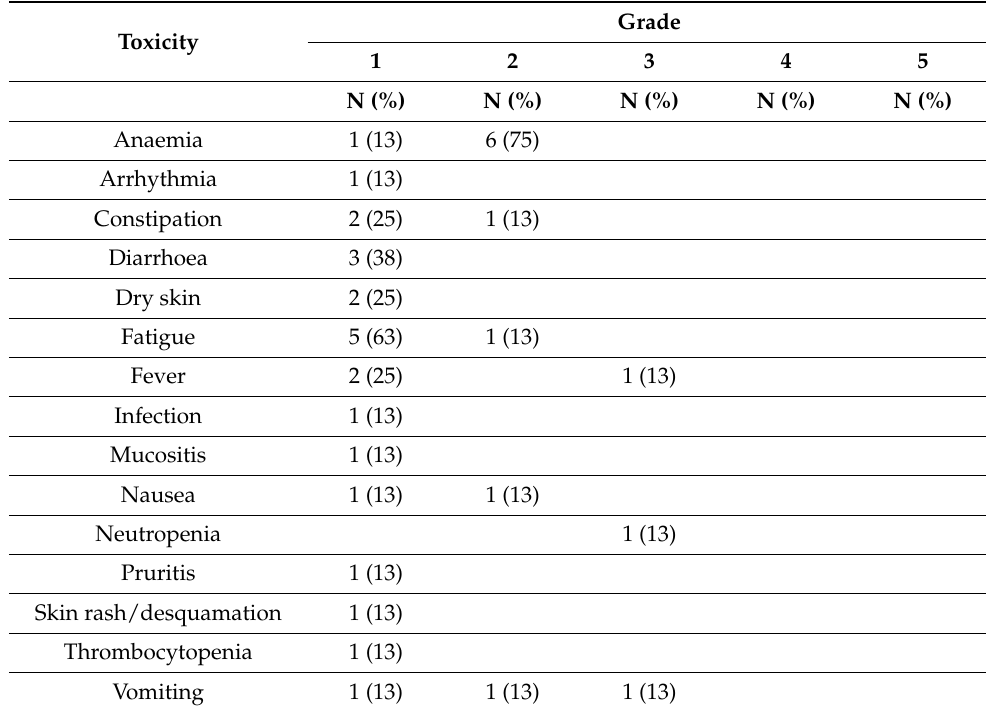
Table 3. Frequency of maximum grade of each toxicity in the treated population ( n =